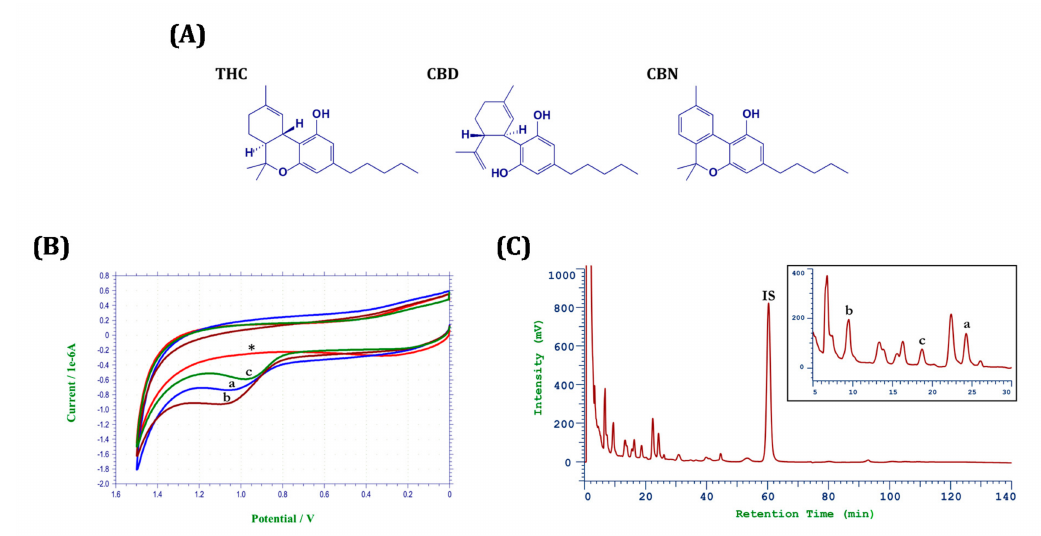
Figure 6. ( A ) Chemical structures, ( B ) electrochemical characterization, and ( C ) HPLC-EC chromatogram for cannabinoids. *: blank, a: THC, b: CBD, c: CBN, IS: internal